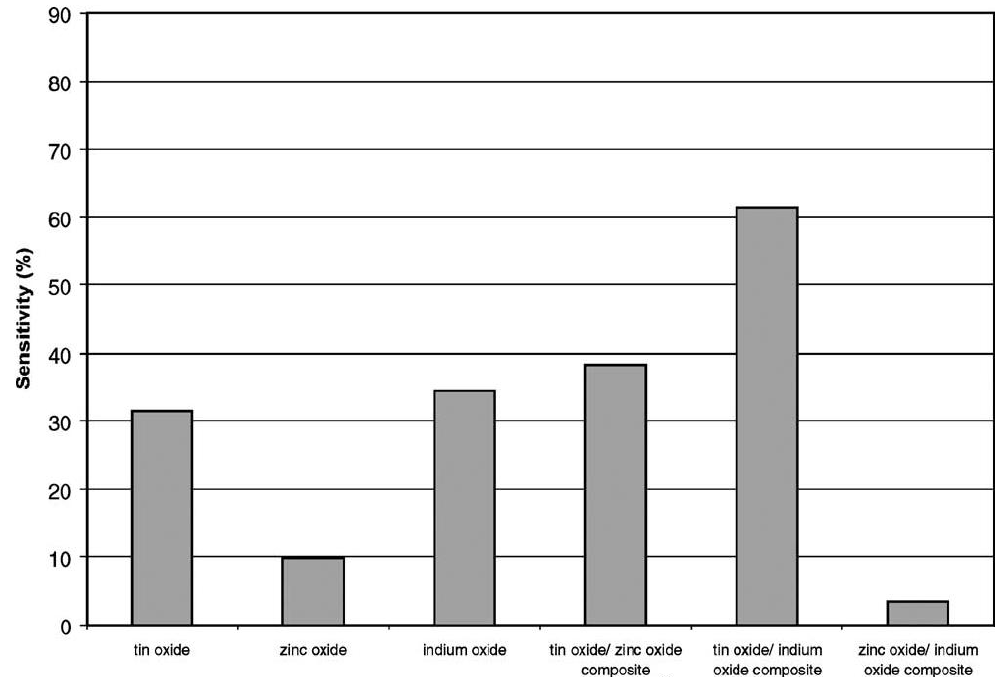
Figure 3. The response of single oxide and composite sensors to 5 ppm ethanol vapour at 100% RH (adapted from